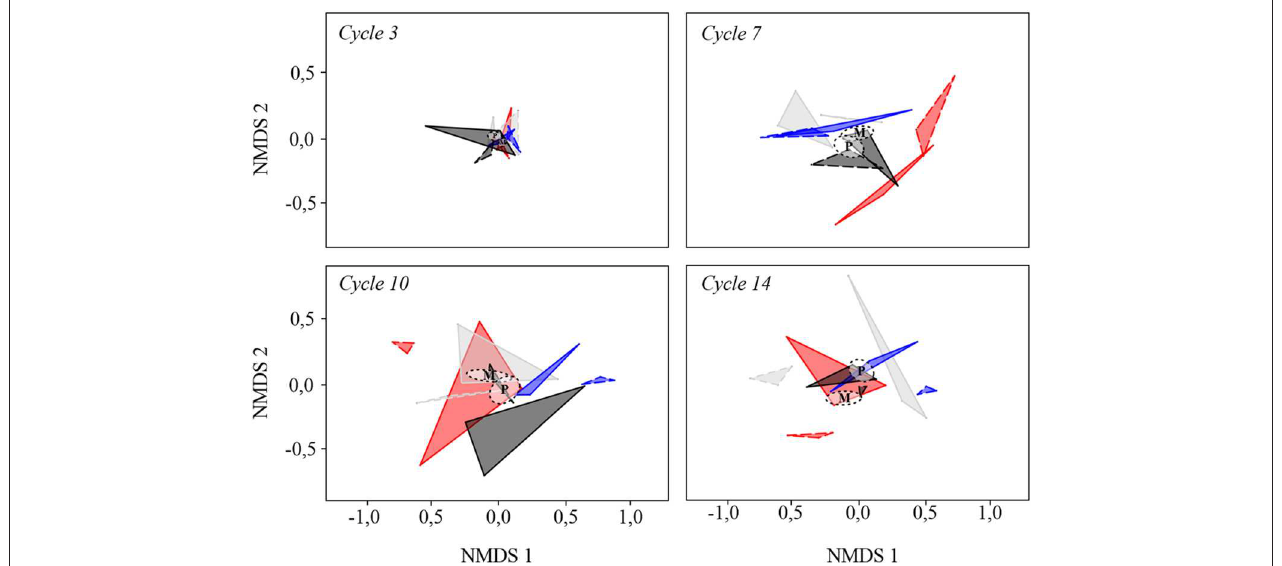
FIGURE 3 | Non-metric multidimensional scaling of community structure over time. Polygons connect communities from the same selection treatment and reproduction method (three communities were analyzed per treatment and cycle). Black, Random; gray, Low; blue, Stabilizing; red, High. Polygons with solid borders: propagule; polygons with dotted borders: migrant pool. For each reproduction method, the centroid position (average position of the communities for a given reproduction method, taking SE into account) is represented by a dotted circle.